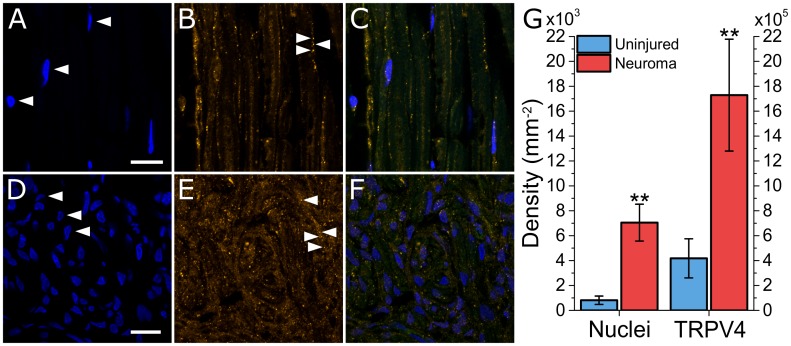
Increased expression of TRPV4 channels and recruitment of non-neuronal cells in 8-week-old amputation neuroma.Representative confocal images (60x with 2x scan zoom) of DAPI-stained cell nuclei ((A, D), blue) and TRPV4 channels ((B, E), gold) in uninjured tibial nerve tissue and within the neuroma bulb, respectively. Scale bar represents 15 μm. (G) Mean density of nuclei and TRPV4 channels (puncta) in uninjured tibial and neuroma tissues (n = 12). Density comparisons were made by 2 sample t-test (** p<0.01).